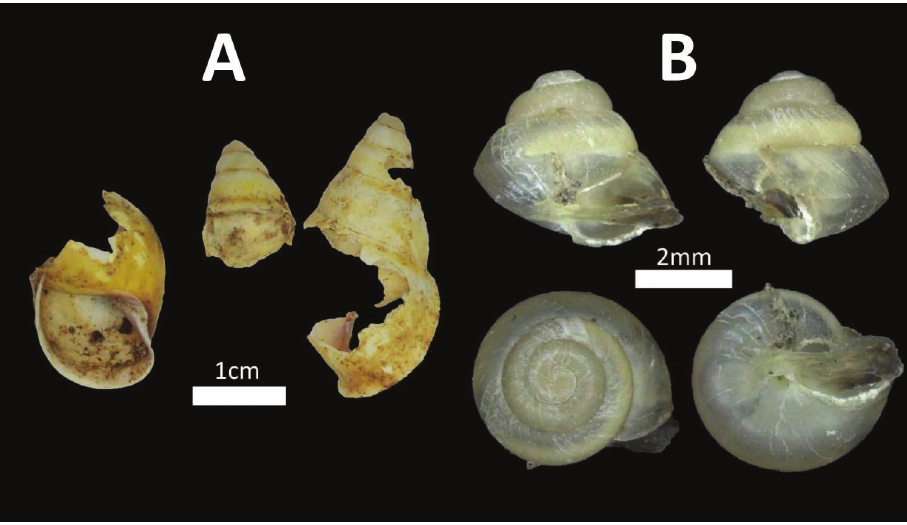
Figure 14. Family Camaenidae. A Amphidromus adamsi adamsi (BOR/MOL 3712) *Broken shell B Ganesella tigaensis (BOR/MOL 6573)